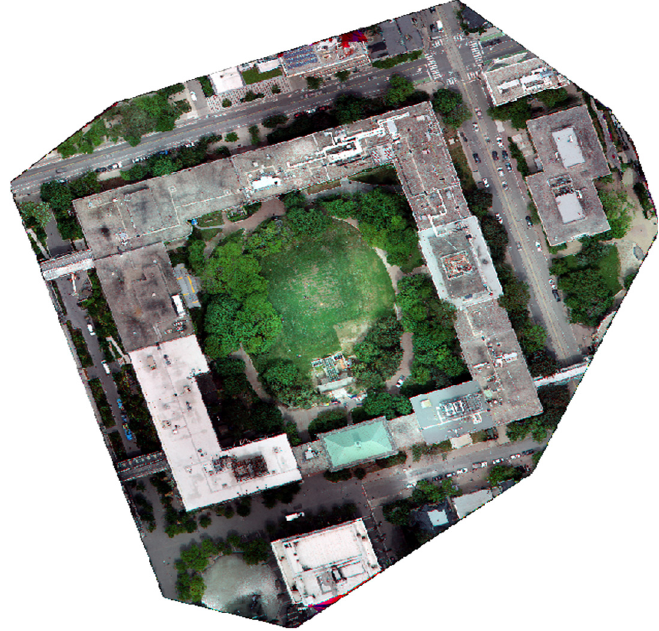
Figure 15. The RGB orthomosaic image for the second test site.